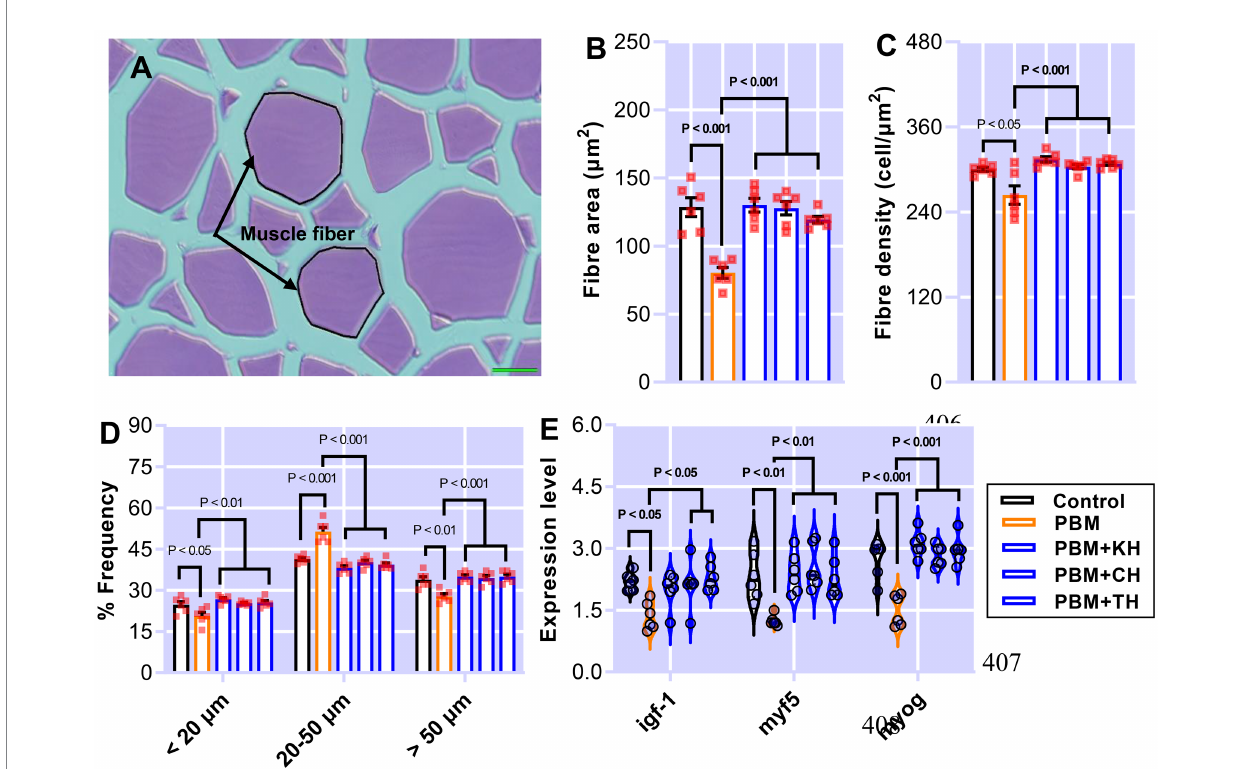
FIGURE 7 The representative histological micrograph of muscle showing the measurements of muscle fiber (A) ; the comparison of quantitative measurements of muscle fiber (B,C) and the frequency percentage of hyperplasia and hypertrophy (D) ; and fold change in the expression of muscle growth relevant genes (E) of barramundi fed FM-based control, PBM alone or supplemented with various FPHs supplemented diet over a period of 42